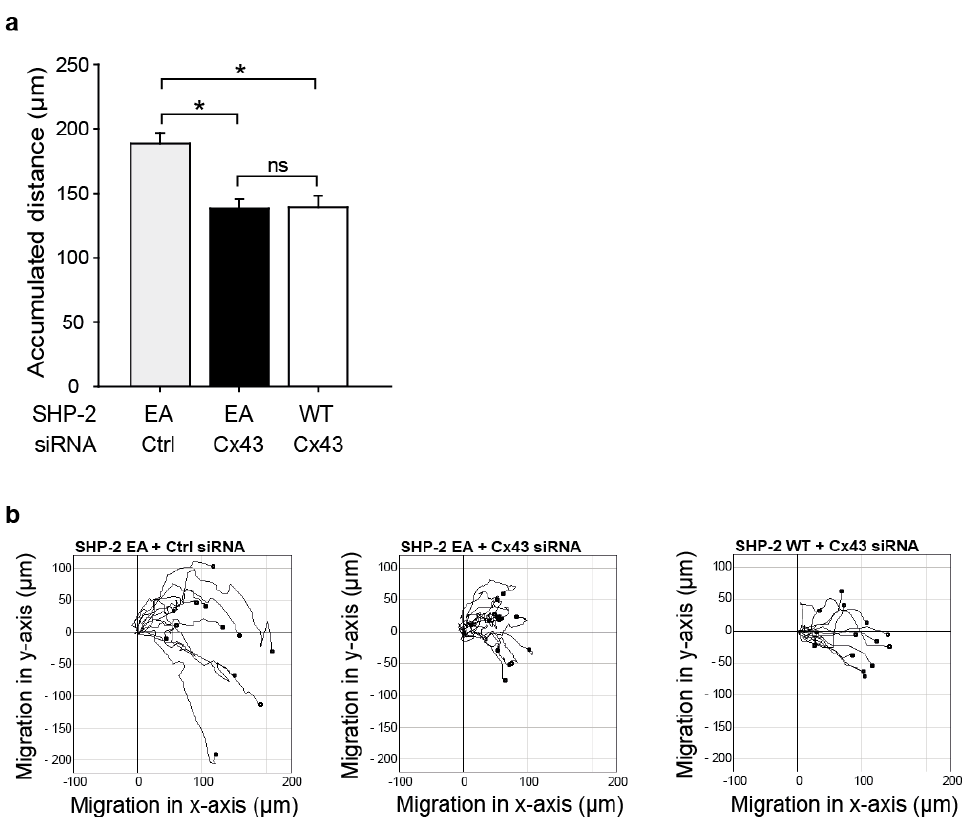
Figure 5. The Cx43 and SHP-2 interaction is vital for endothelial migration. ( a ) Treatment of HMEC overexpressing a constitutively active mutant SHP-2 (SHP-2 EA) with Cx43 siRNA did not rescue the reduced migratory response caused by Cx43 knock-down (Cx43 siRNA) (ns: not significant, n = 3 independent cell cultures) compared to SHP-2 EA cells treated with control siRNA (Ctrl) (* p < 0.05, n = 3 independent cell cultures), as assessed by the accumulated distance in µm in an in vitro wound assay (* p < 0.05, n = 3 independent cell cultures). ( b ) Representative single cell traces of migrated HMEC.